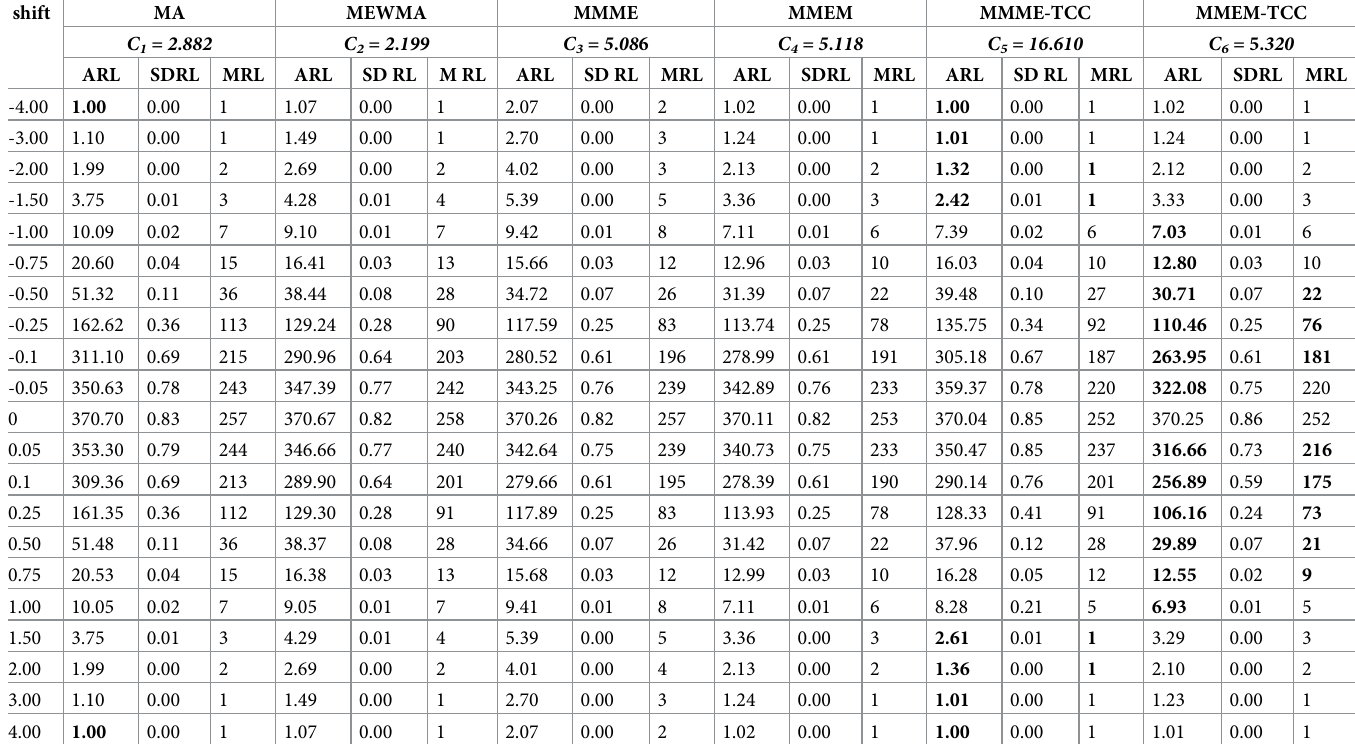
Table 1. The run length attributes of the proposed MMEM-TCC chart and existing control charts for normal